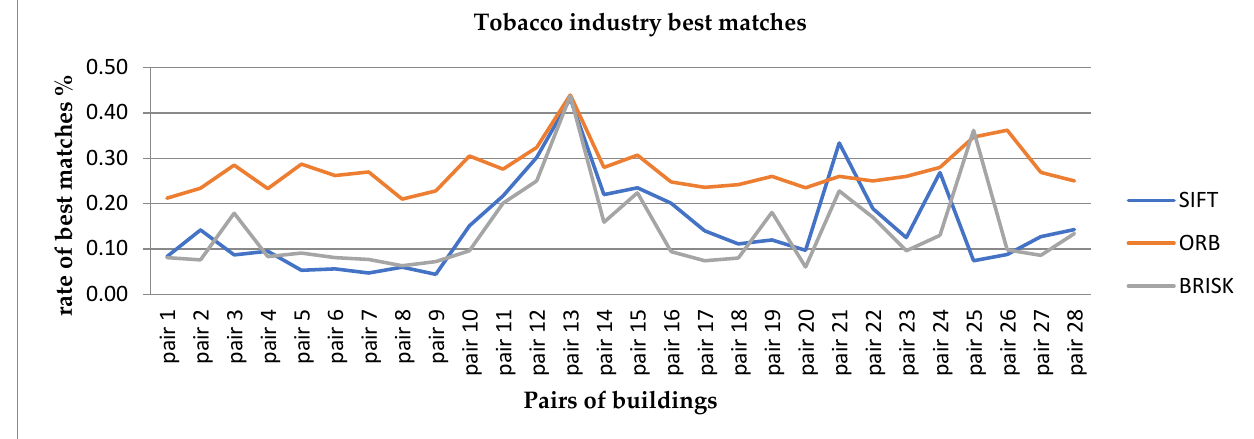
Figure 18. Tobacco industry: rate of the best matches from pairs of buildings over time.